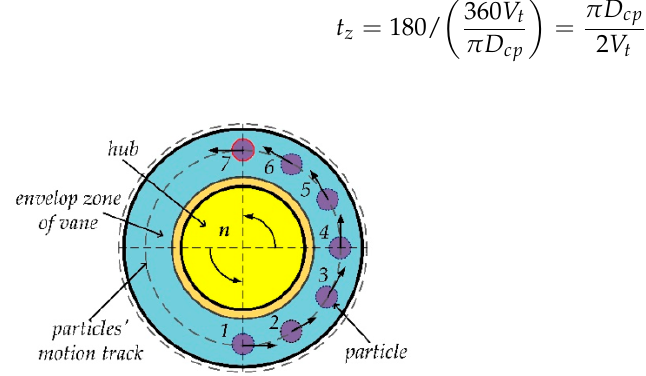
Figure 5. The schematic of the theoretical track of particle with coal